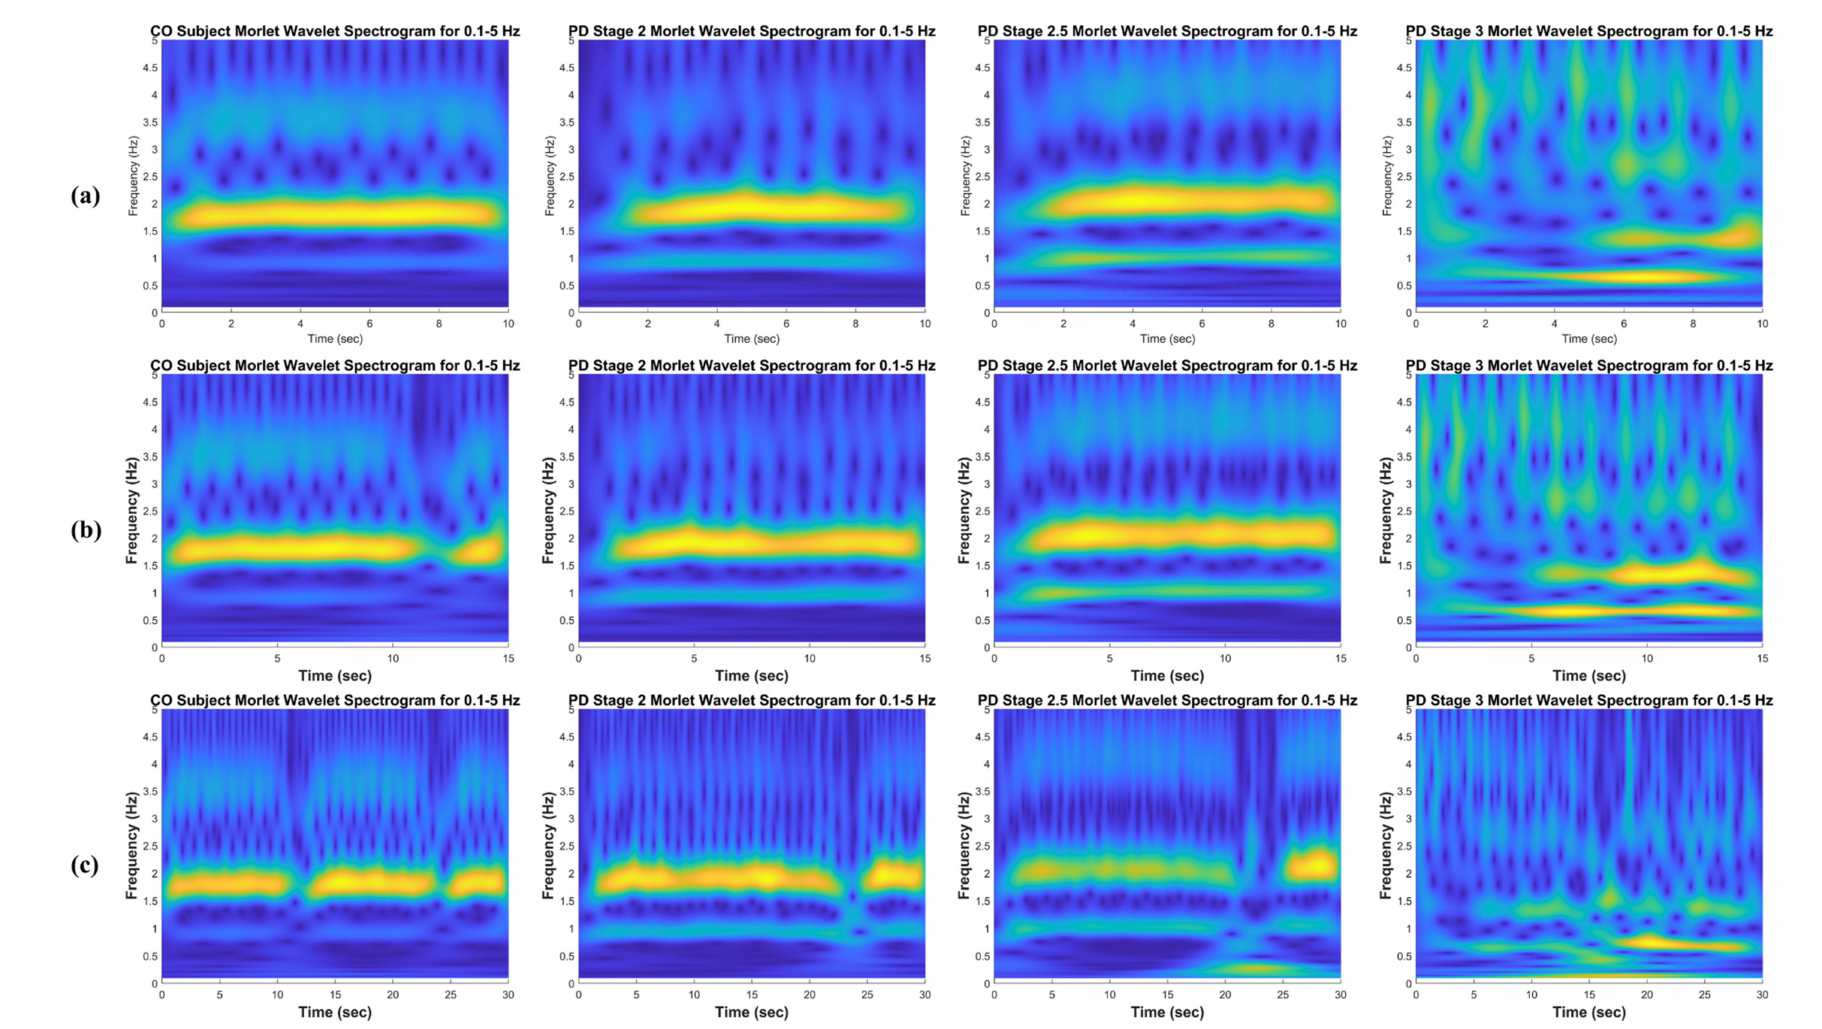
Figure 4. Time-frequency spectrograms using CWT of the CF vGRF signals of CO, PD Stage 2, PD Stage 2.5, and PD Stage 3 subjects in the 0.1–5 Hz frequency range for ( a ) a 10 s time window size, ( b ) a 15 s time window size, and ( c ) a 30 s time window size from Ga [21]